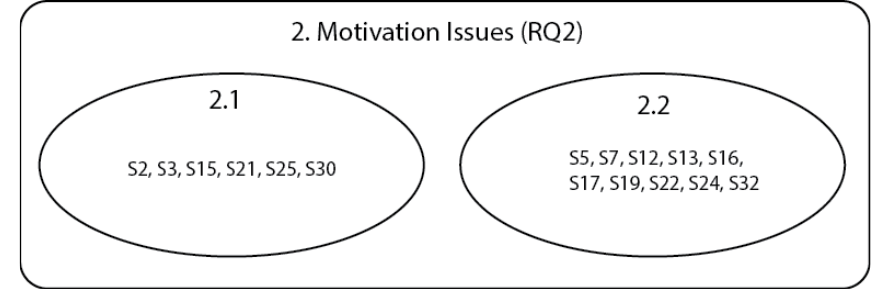
Figure 6. Types of motivation issues ( RQ2